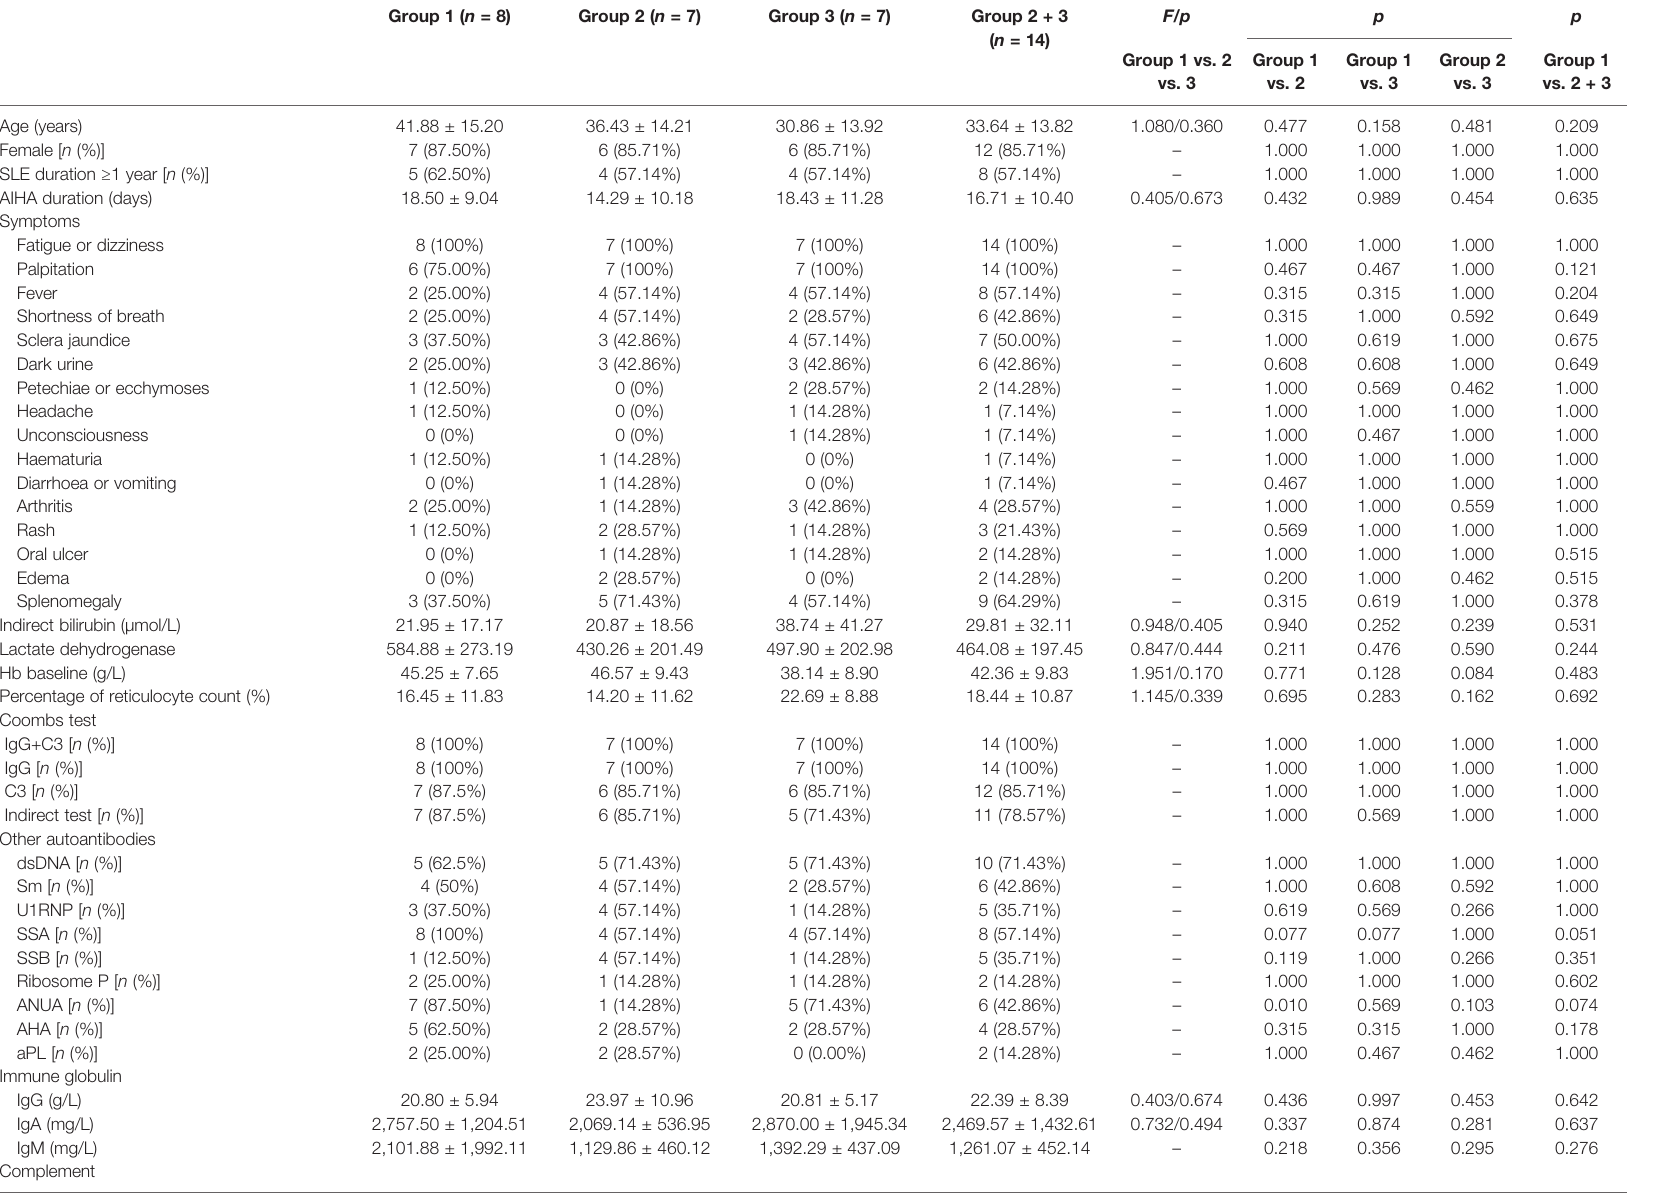
TABLE 1 | Baseline clinical characteristics and treatment condition of patients from 3